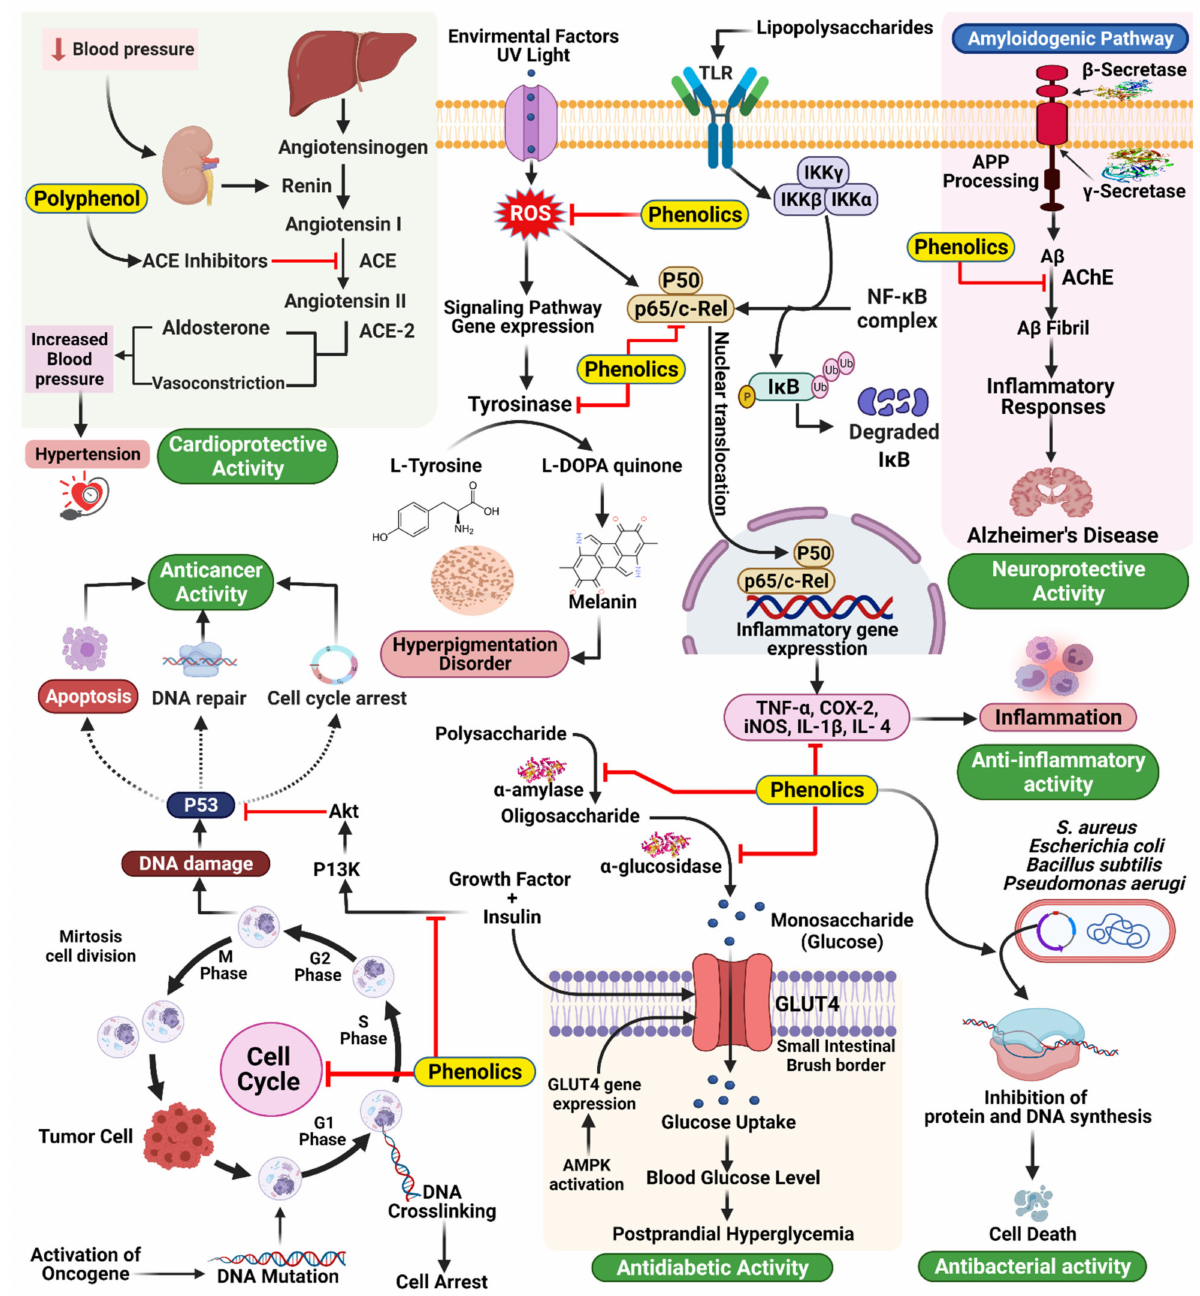
Figure 7. Mechanism of action underlying the therapeutic activities of phenolics in different diseases. Delaying glucose absorption through inhibiting -glucosidase activity is one potential treatment option for type 2 DM prevention. Terminalia chebula fruits contain phenolics that present significant enzymatic inhibitory activity against mammalian-glucosidases, which could contribute to the management of blood glucose levels in patients with type 2 DM without causing severe adverse effects Quercetin, kaempferol, luteolin, quercetagetin, and scutellarein are naturally occurring flavonoids that function as inhibitors of human α -amylase, making them intriguing candidates for limiting starch digestion (Figure 7) [34]. Natural health substances including non-flavonoid polyphenols (e.g., resveratrol, curcumin, tannins, and lignans), flavonoids (e.g., anthocyanins, epigallocatechin gallate, quercetin, naringin, rutin, and kaempferol), plant fruits, vegetables, and other products (e.g., garlic, green tea, blackcurrant, rowanberry, bilberry, strawberry, cornelian